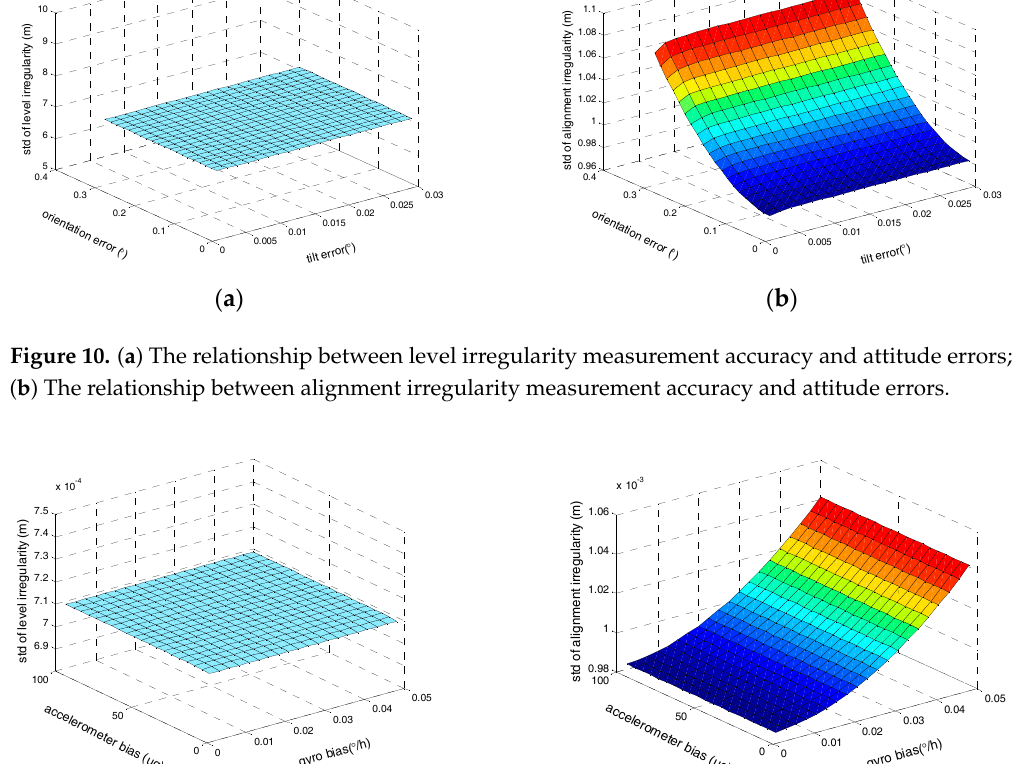
( b ) Figure 12. ( a ) The distribution of level irregularity measurement accuracy; ( b ) The distribution of alignment irregularity measurement accuracy.